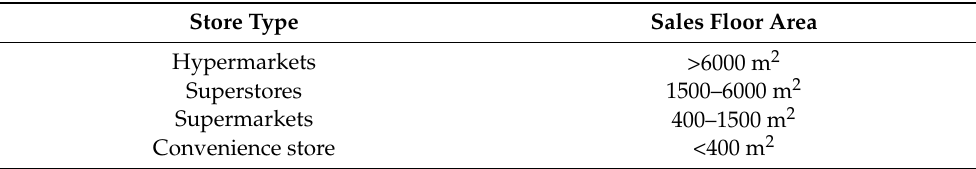
Table 1. A possible classification of food retail structures.